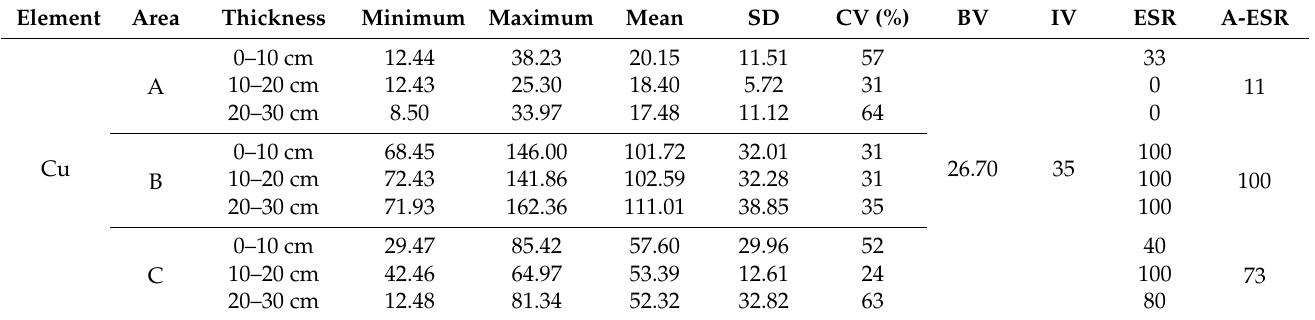
Table 2. Descriptive statistics of the soil heavy metal content in the study